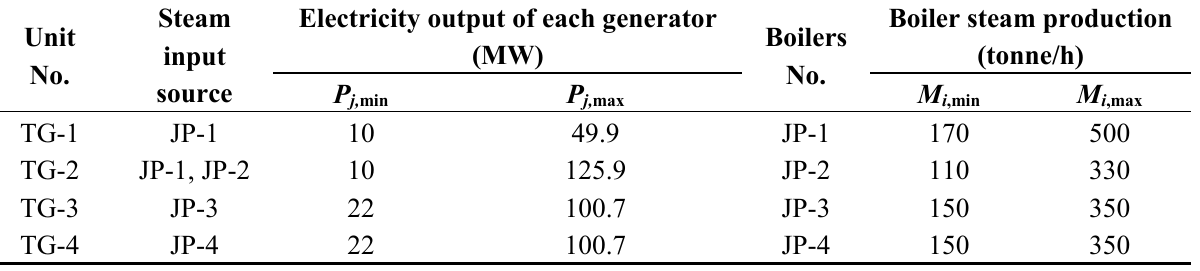
Table 5. Upper and lower limits of in-plant boilers and steam